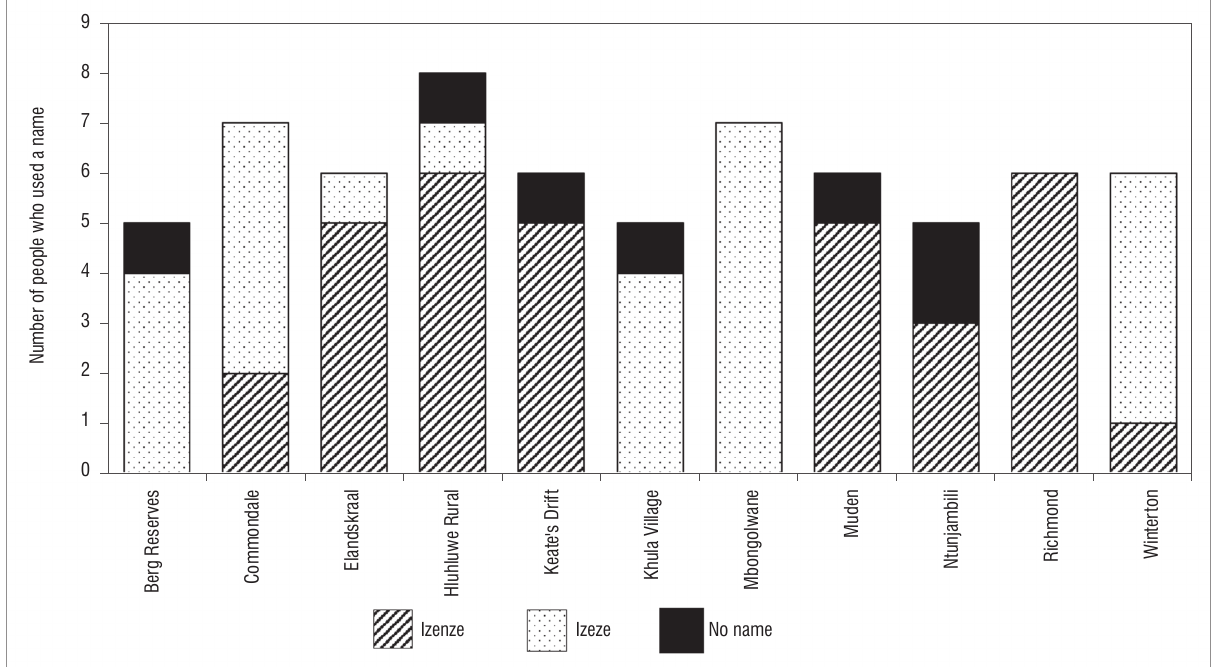
Figure 6: The isiZulu name for fleas (Siphonaptera: Pulicidae) varies across regions. The term izenze is more common in the centre of the province (Elandskraal, Muden, Keate’s Drift, Ntunjambili, Hluhluwe), and izeze is more common in the peripheral coastal (Mbongolwane, Khula Village) and mountain (Berg reserves, Winterton, Commondale) regions (cf. Figure